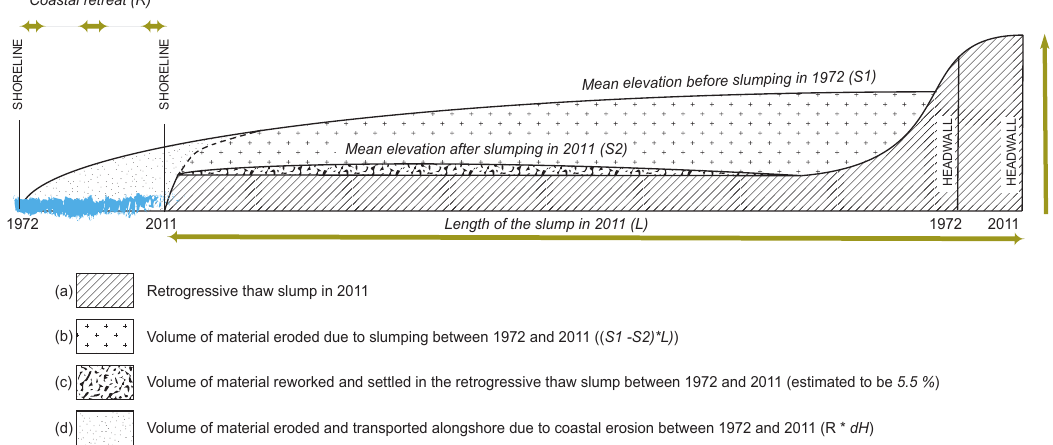
Figure 4. Cross section of a retrogressive thaw slump (RTS) (a) illustrating the calculated volumes of sediments eroded through slumping between 1972 and 2011. The calculation estimates the amount of material released to the nearshore zone through slumping (b) and takes into account the material eroded from the RTS headwalls that remains within the RTS floors where it settles (c) and (d) the material eroded and transported alongshore by coastal erosion. The volume of material that remains within the RTS floors was estimated from Obu et al.